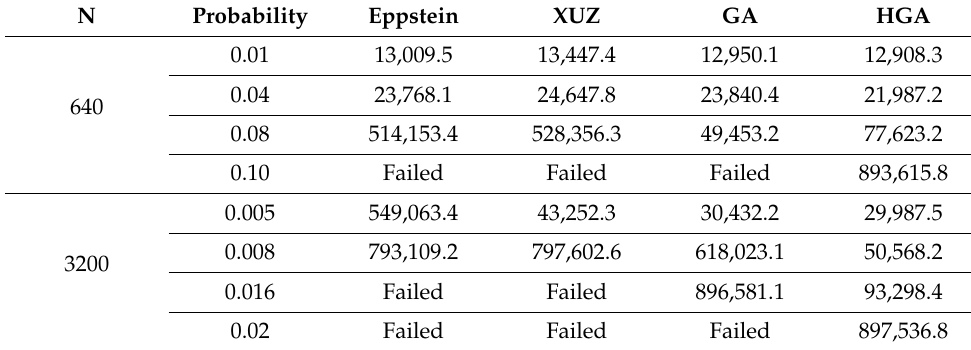
Table 6. Memory consumption of counterexample